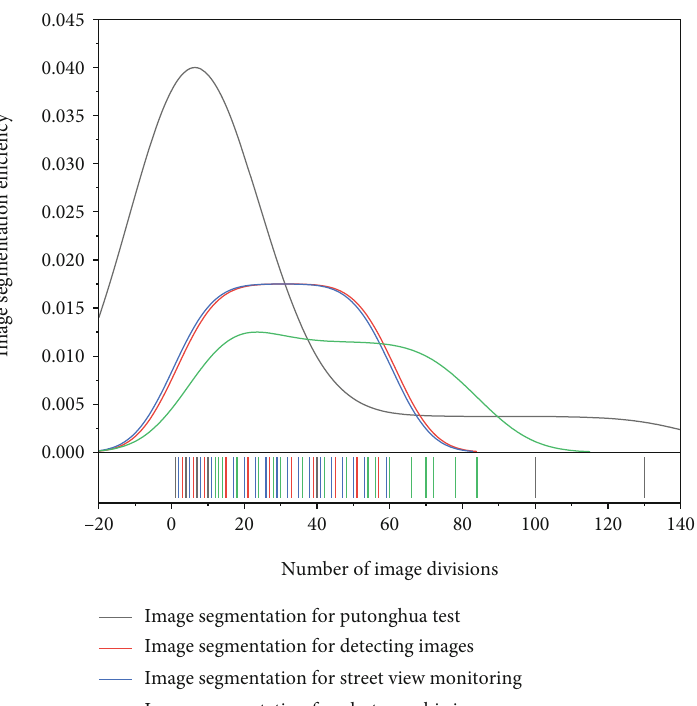
Figure 7: The image histogram.